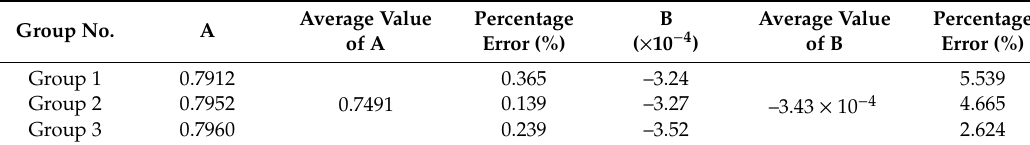
Table 3. Fitting parameters of A and B for three groups of tests.